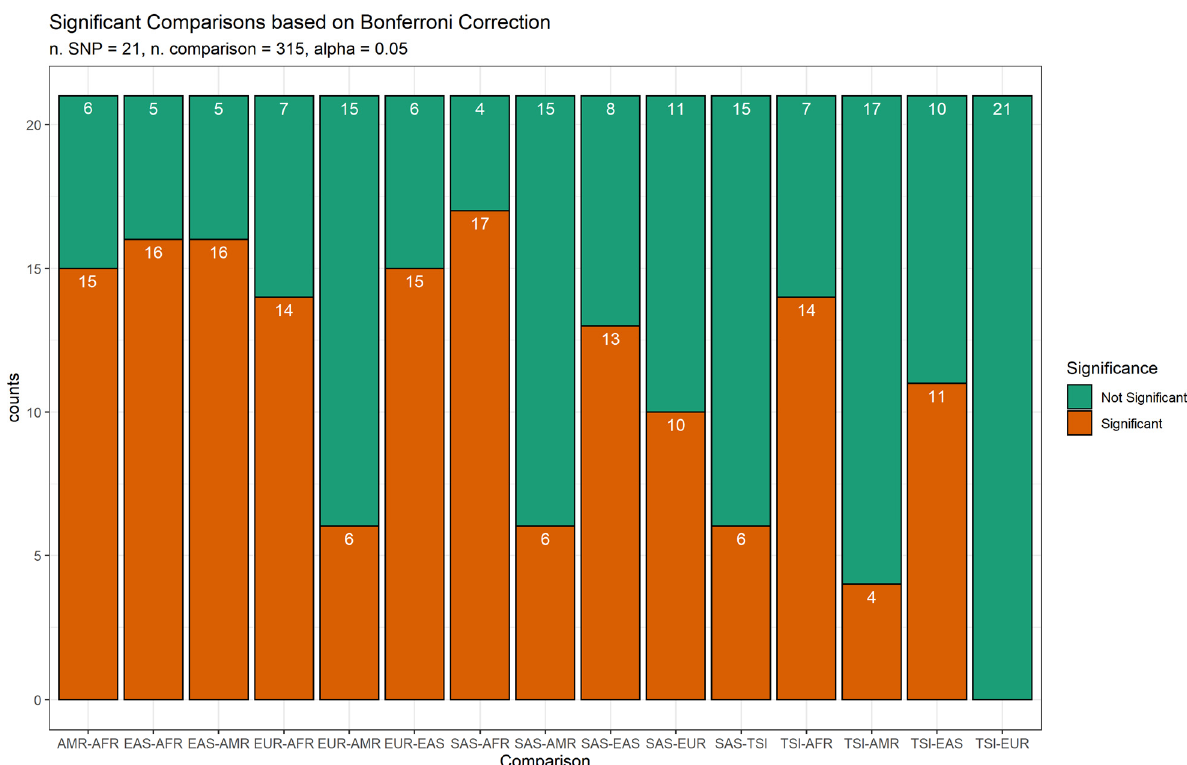
Figure 1. Comparison of variants frequency across populations. Bars indicate the overall number of variants with significant (orange) and not-significant (green) differences in frequencies between populations. Abbreviations: African (AFR), American (AMR), East Asian (EAS), European (EUR), Toscani in Italy (TSI) and South Asian (SAS).